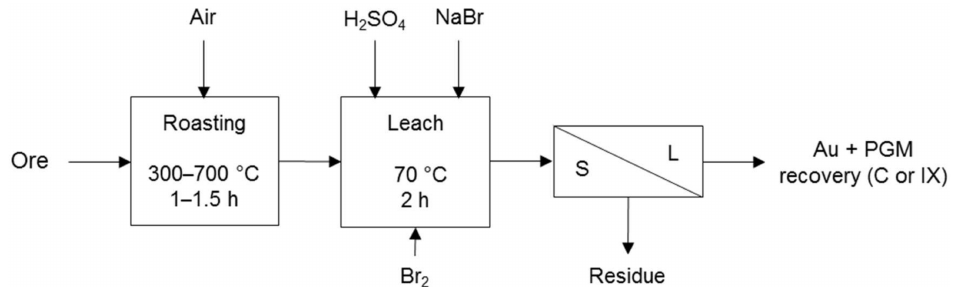
Figure 5. Simplified TML process diagram for Hartley oxide ore. Other leach parameters were 100 g/L H 2 SO 4 , 10 g/L NaBr, >800 mV ORP with Br 2 using Geobrom 3400 as oxidant, and 24–40% solids. Adapted from Cole and Ferron [7]. Geobrom 3400 is a sodium bromide solution in which liquid bromine is